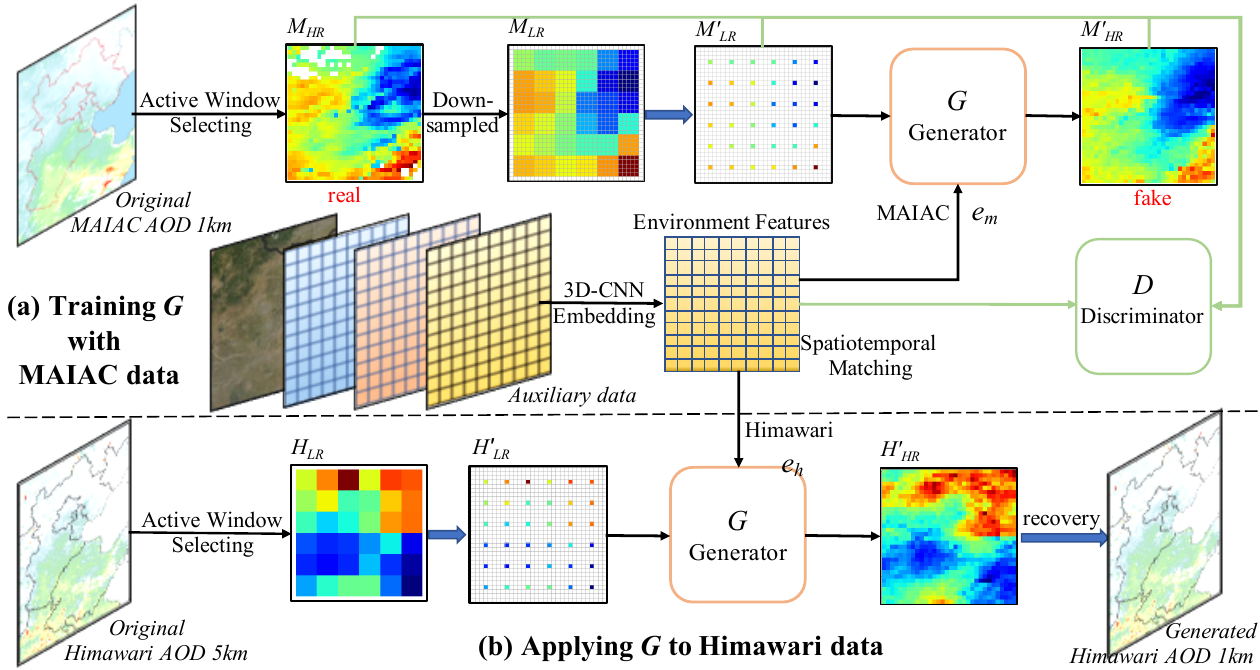
Figure 1. Flowchart of the proposed method, including data preprocessing, model training, and applying. Stage ( a ) is training generator G with MAIAC AOD data; Stage ( b ) is applying the trained generator G to Himawari AOD data. The 3D-CNN is used to extract environment features from auxiliary data. Spatiotemporal matching is required when using the environment features in the